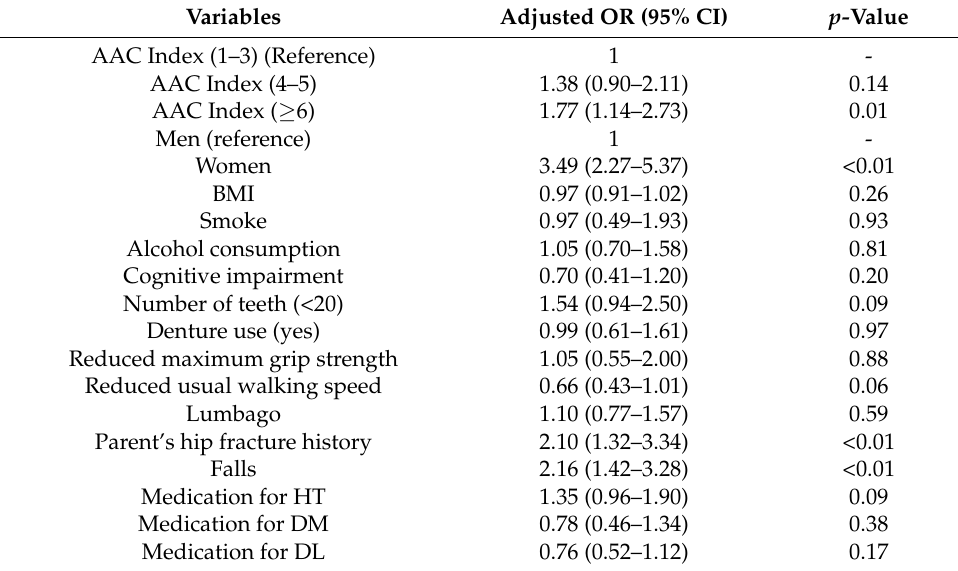
Table 4. Adjusted odds ratio for